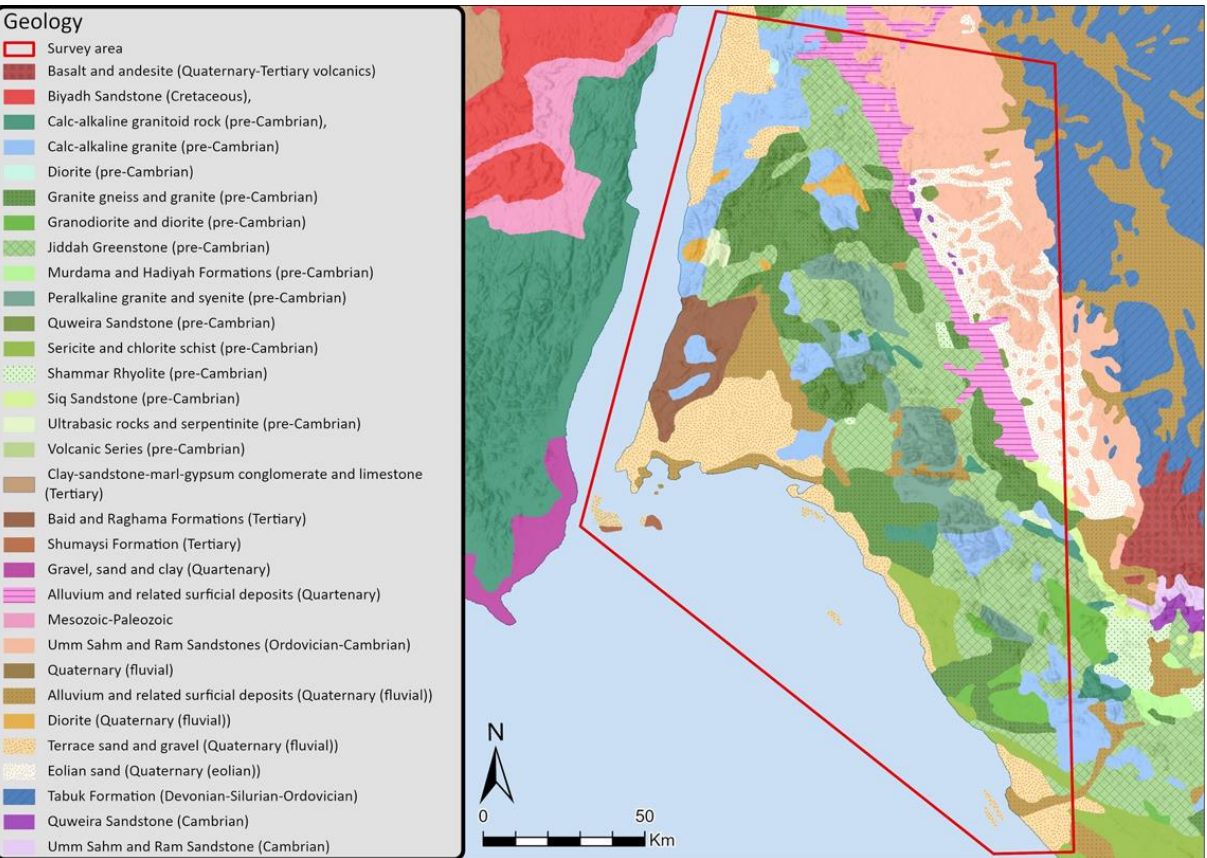
Figure 2. The geology of the survey area, adapted from [5 – 6]. Figure 2. Highlighting the Neom impact areas based on published plans. The red line relates to the Line